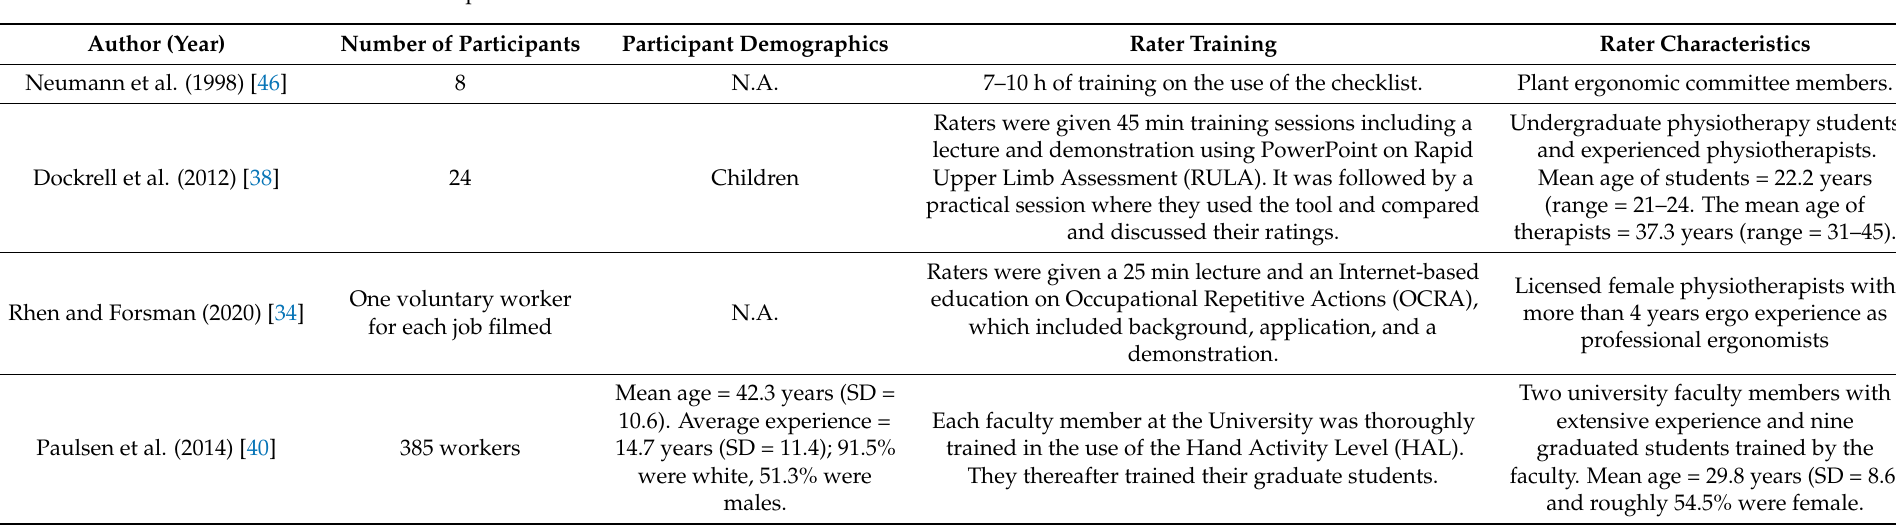
Table 2. Participant and Rater information for the articles included in the review a